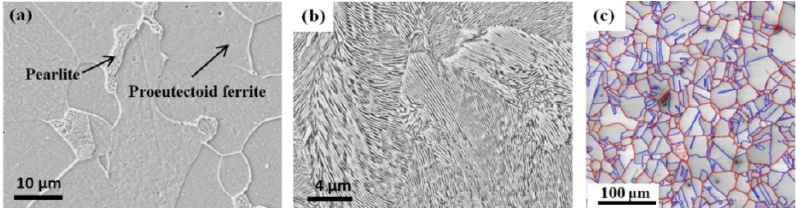
Figure 5. Comparison of the typical microstructures of hot-rolled ( a ) ferritic, ( b ) pearlitic, and ( c ) TWIP steels. Red and blue lines in the last figure indicate the high angle grain boundaries ( − θ ≥ 15°) and Σ 3 twin boundaries ( − Σ 3), respectively.